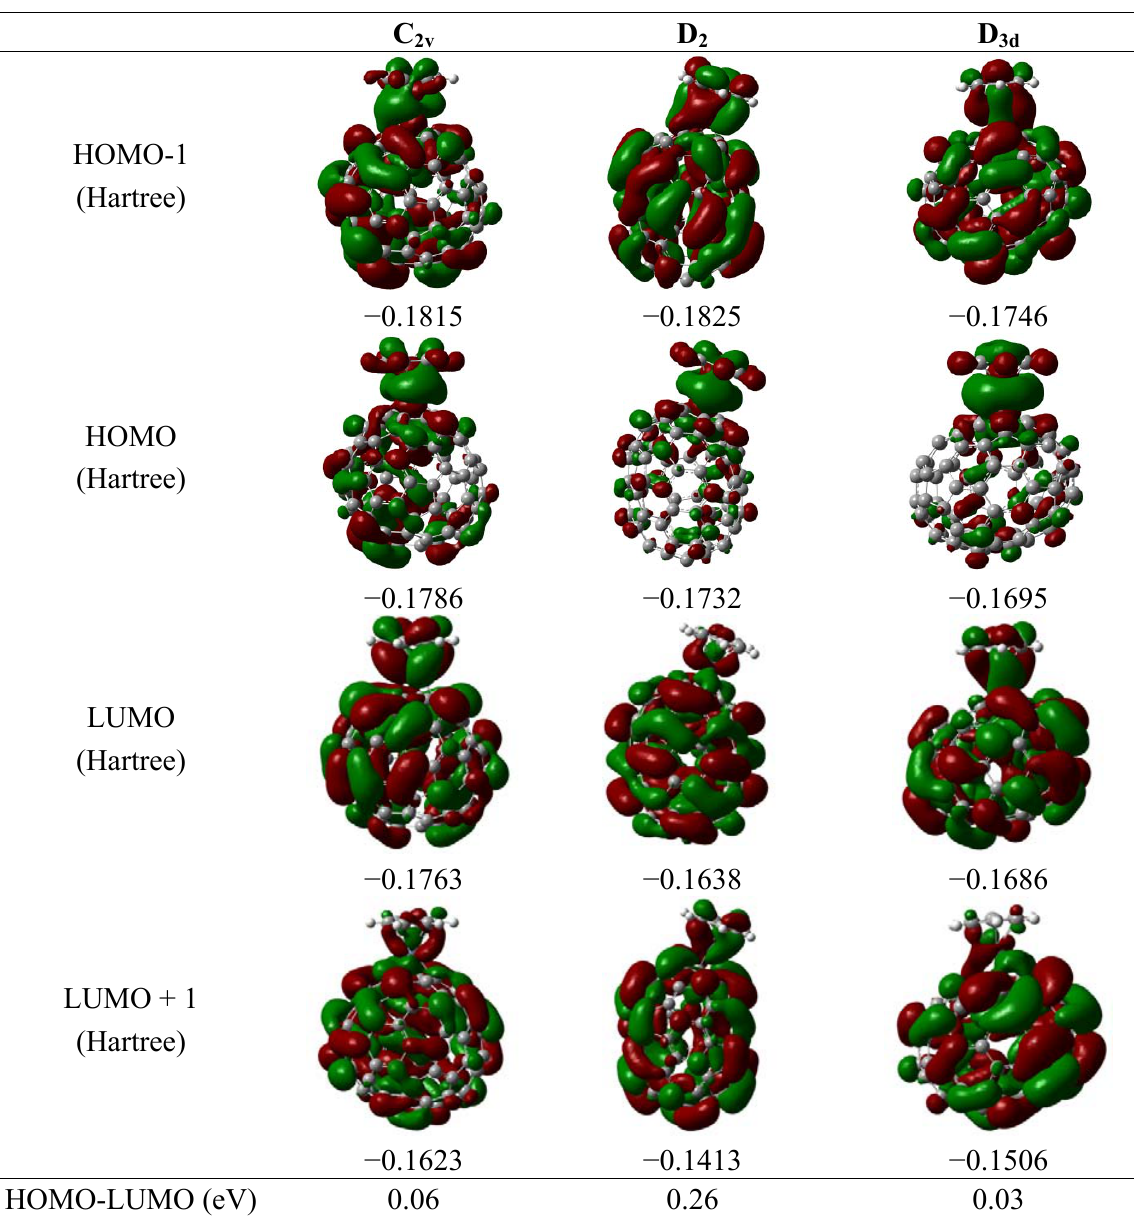
, D and D 2v 2 3d